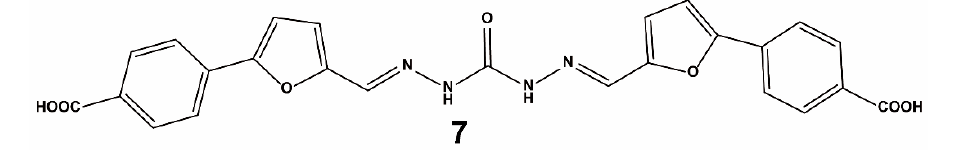
Figure 6. Structure of compound 7 .